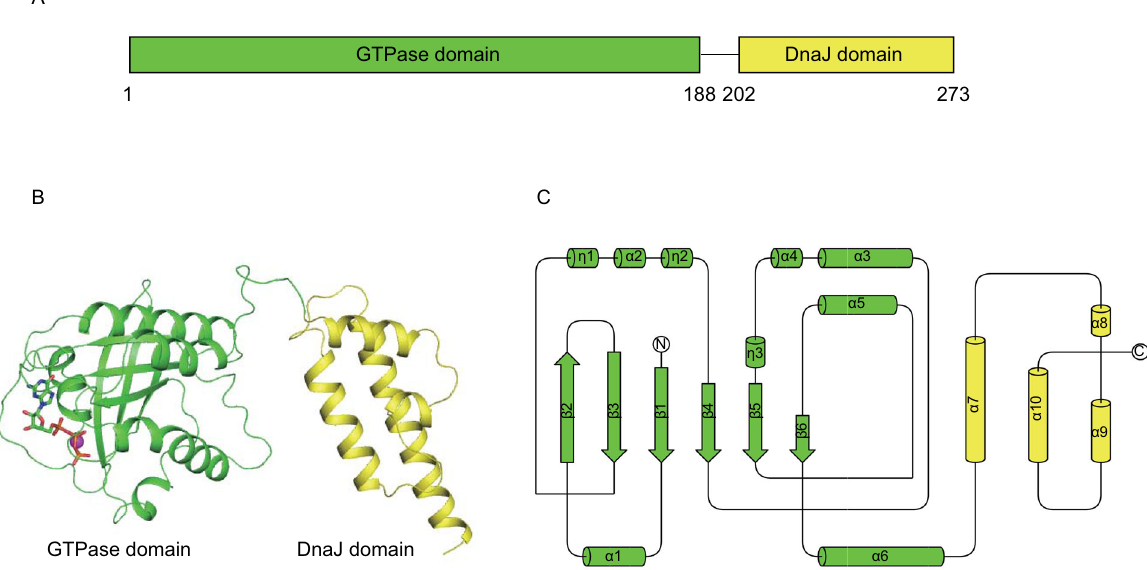
Figure 1. Crystal structure of xRbj . (A) Schematic picture of xRbj. The GTPase domain and DnaJ domain are shown in green and yellow, respectively. (B) Cartoon representation of the crystal structure. The GTPase domain and DnaJ domain are colored the same as Fig. 1A. GTP is displayed in stick format and the Mg 2+ cation is represented as a magenta sphere. (C) Topology diagram of the GTPase domain and DnaJ